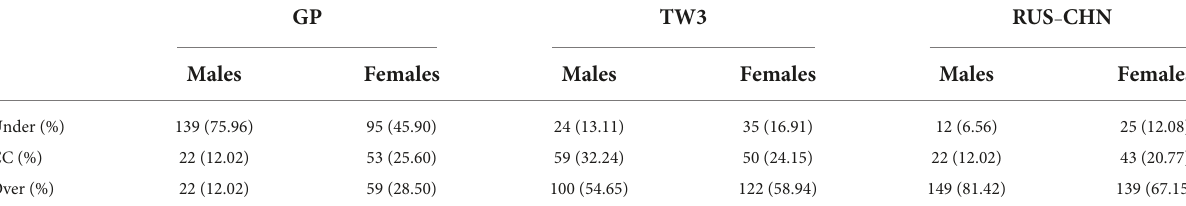
TABLE 1 Percentages of subjects with correctly classified (CC), underestimated (under), and overestimated (over) age with respect to the class of CA ± 3